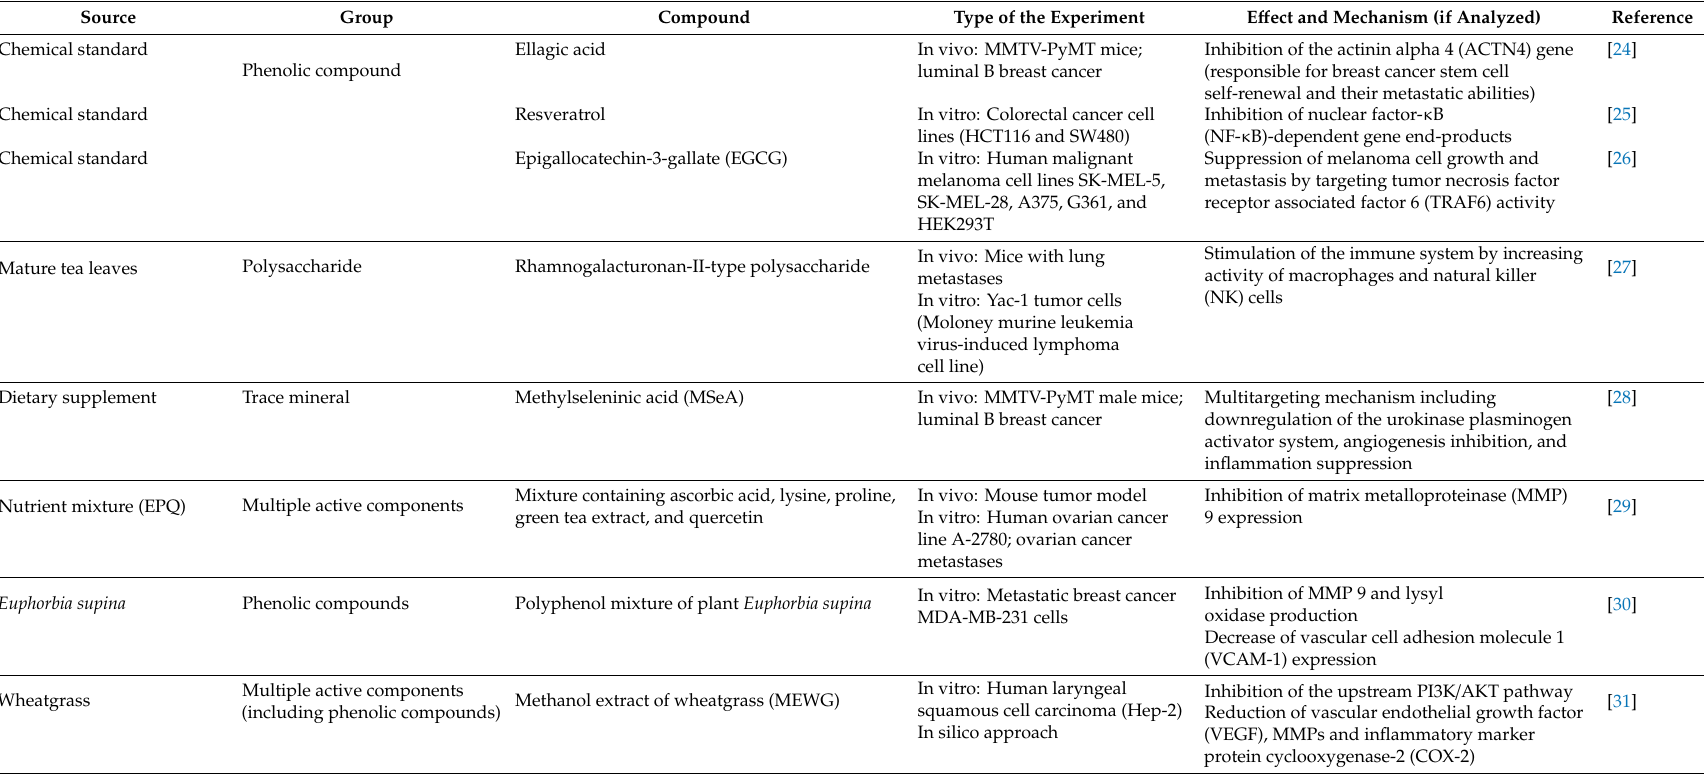
Table 2. List of nutraceuticals (single biologically active compounds or mixtures) that could be used in the prevention of metastasis